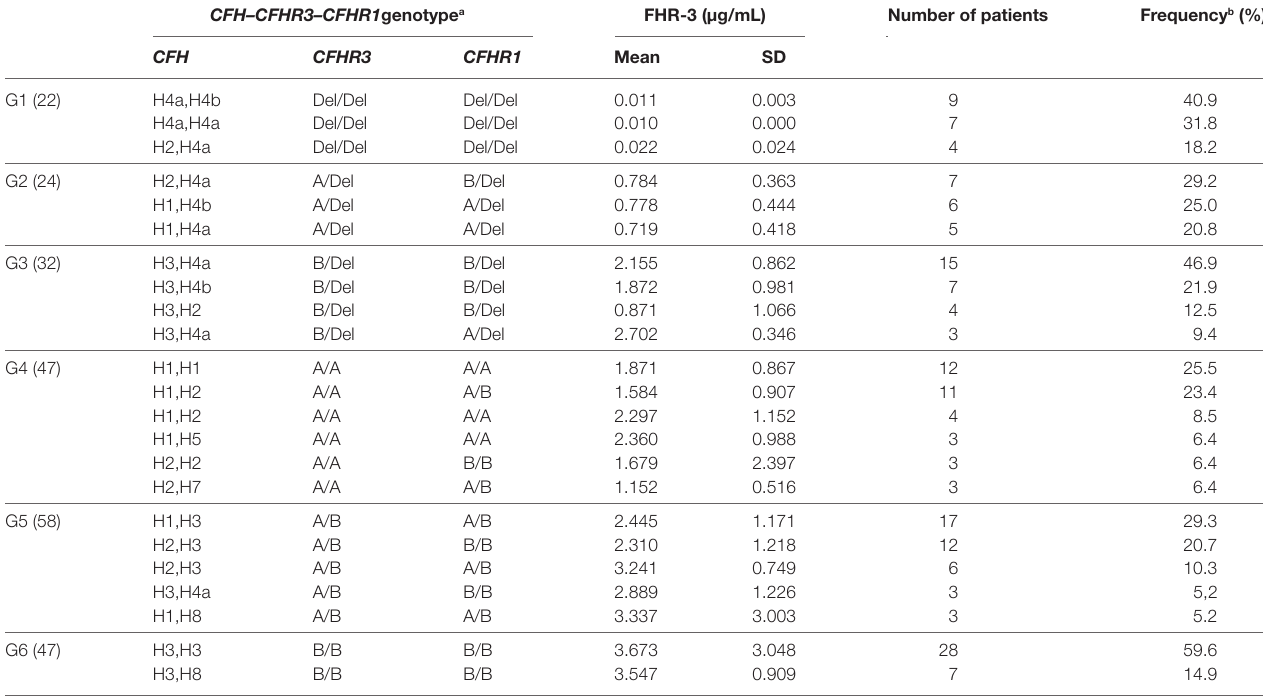
Table 3 | CFH–CFHR3–CFHR1 genotypes and FHR-3